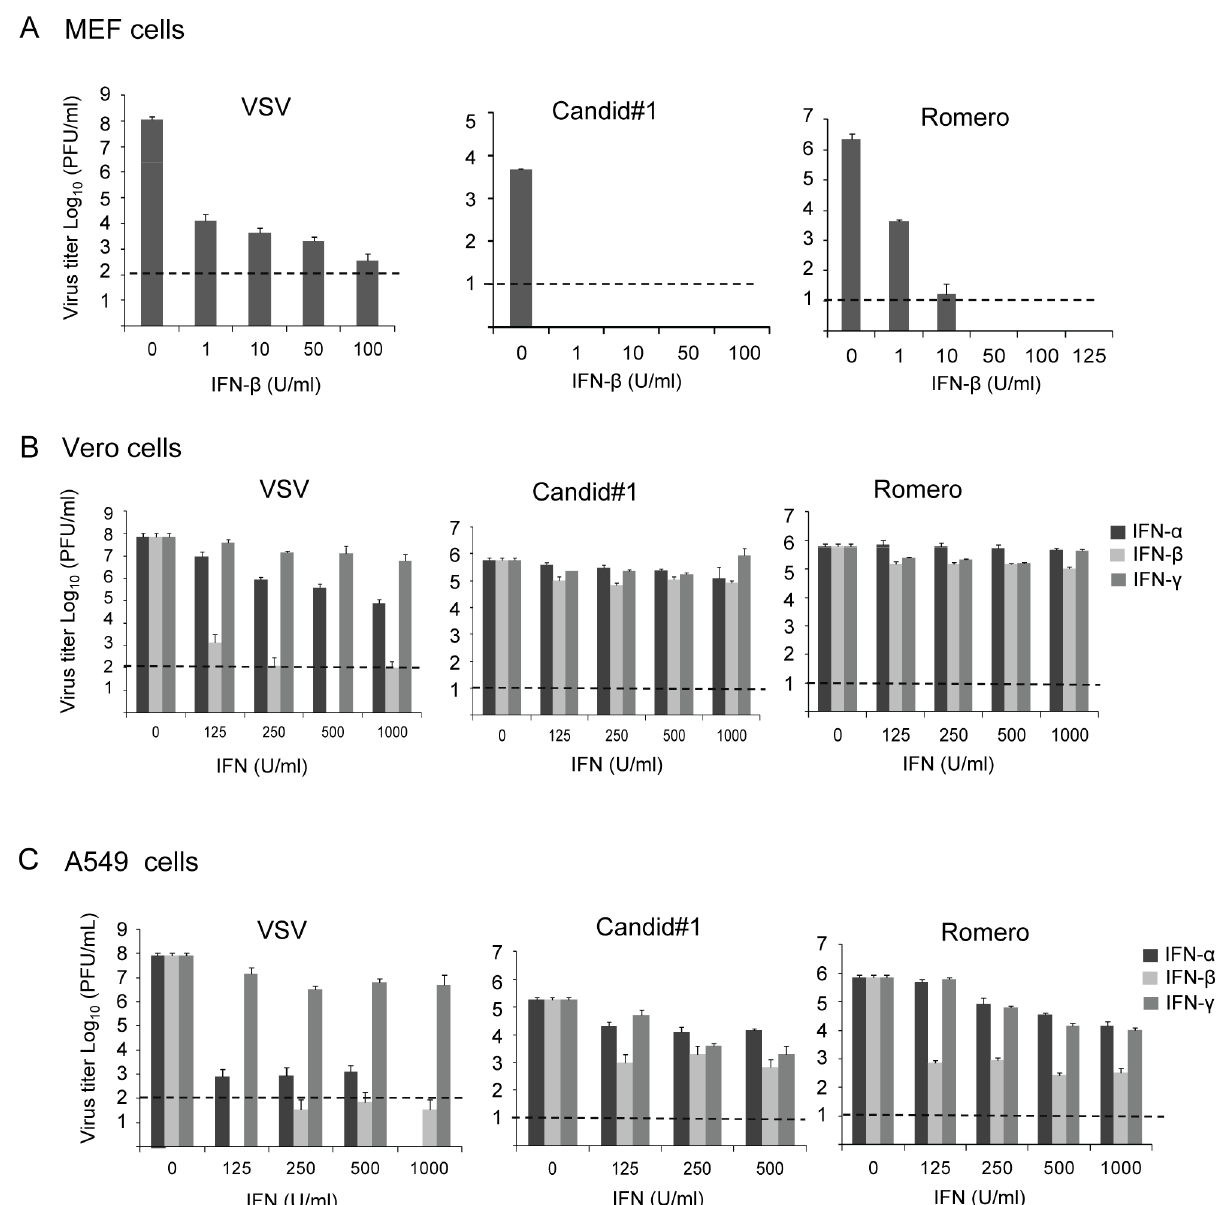
Figure 1. Interferon sensitivity of JUNV in different cell lines. (A) mouse embryonic fibroblast cells (MEF), (B) Vero cells (ATCC) and (C) human lung carcinoma epithelial A549 cells (ATCC) were treated with IFNs at the indicated concentrations for 16 h. Vero cells and A549 cells were treated with human IFN- a 2b (Schering), IFN- b (PBL) or IFN- c (Sigma), while MEF cells were treated with mouse IFN- b (PBL), respectively. Cells were then infected with VSV, Candid # 1 JUNV or Romero JUNV at an MOI of 0.1 PFU/cell. IFNs were supplemented after virus infection. During Romero and Candid # 1 JUNV infection, supernatants were collected at 3 days p.i. and assayed for virus production by plaque assay. During VSV infection, supernatants were collected at 16 h.p.i.. Dotted lines indicate the limitation of plaque assay. Data represent the mean of three experiments 6